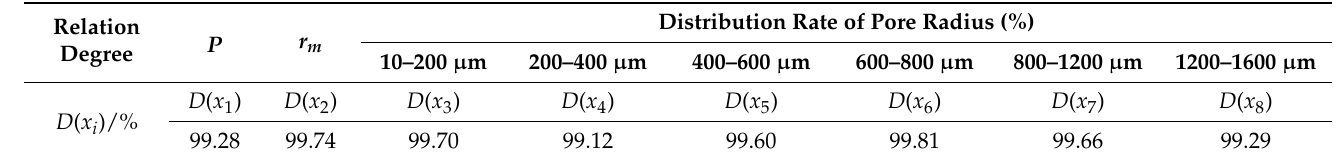
Table 4. Relation degree of GRE (data